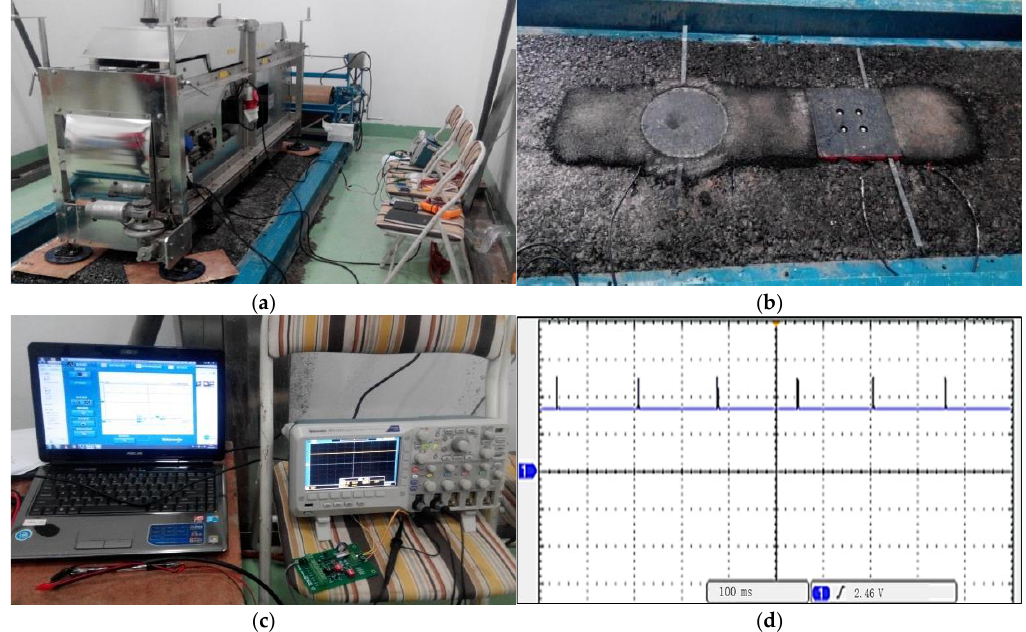
Figure 16. The laboratory pavement loading test of the PEH road. ( a ) The accelerated pavement testing device. ( b ) The laboratory test road. ( c ) Monitor system of the voltage. ( d ) Voltage waveform of the energy storage capacitor.